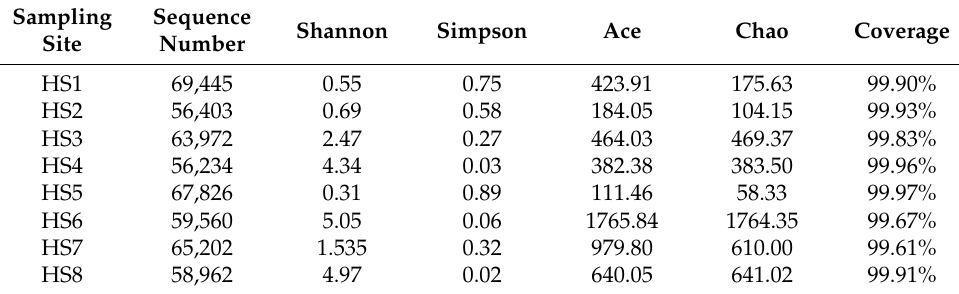
Table 2. Diversity index of microorganisms in each sampling